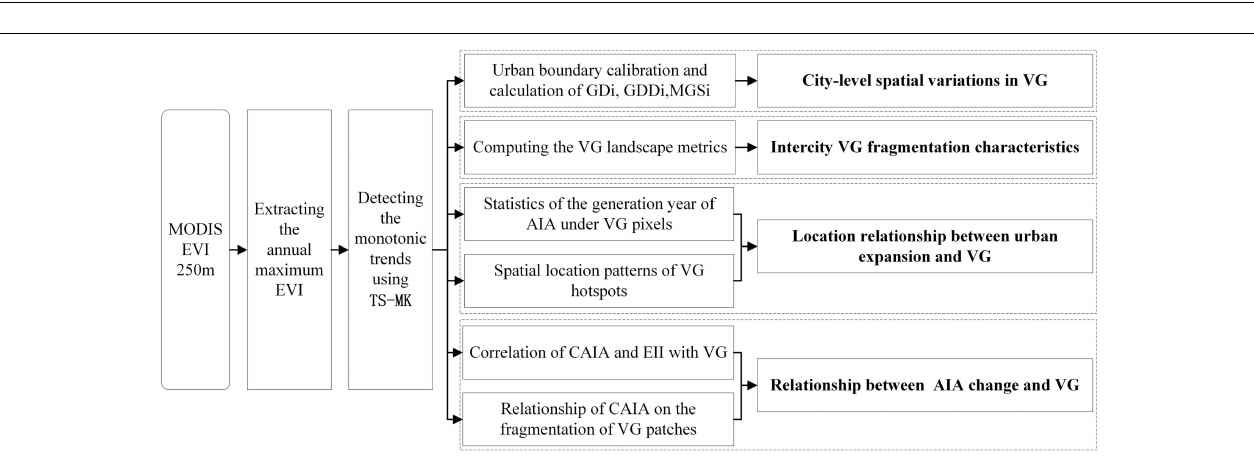
FIGURE 1 | Spatial distribution of the selected 439 Chinese cities. Different colors indicate the first level of eco-geographic regional system. Colored zones were the focus of the statistical analysis. Green dots represent the locations of the 439 cities selected.